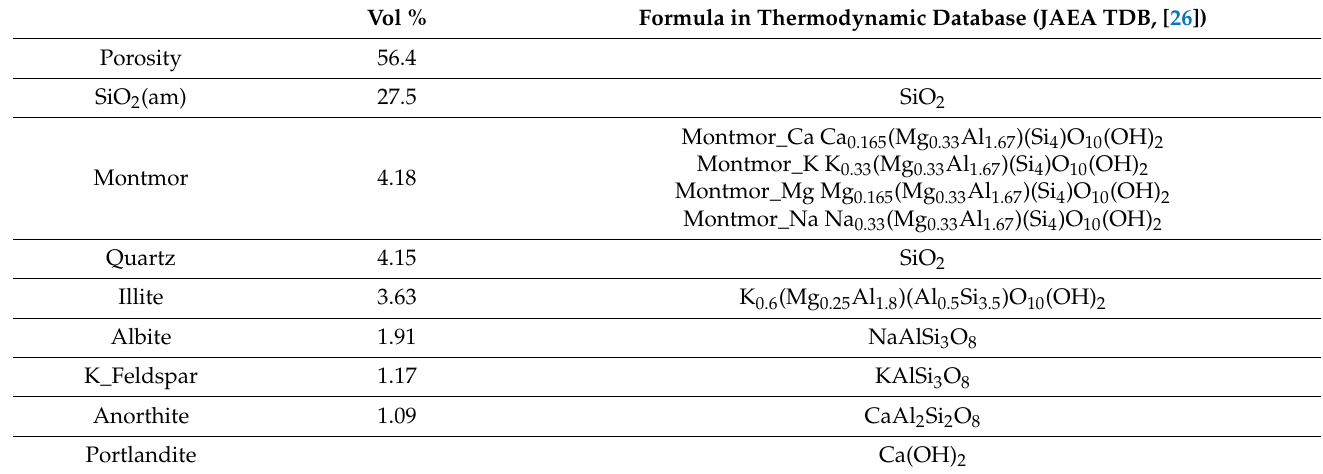
Table 2. Details of the ‘model’ Horonobe mudstone composition and potentially active minerals. Vol